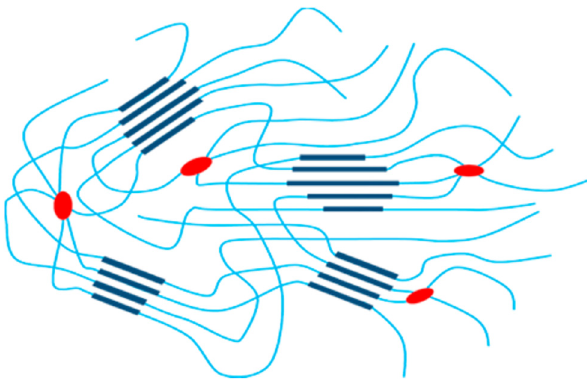
Figure 13: Molecular representation of the semicrystalline poly - amide. Crystalline polymer ( dark blue ) is embedded in an amor - phous matrix ( light blue ) , and red dots represent covalent cross - link points ( 119 ) . Reproduced with permission from